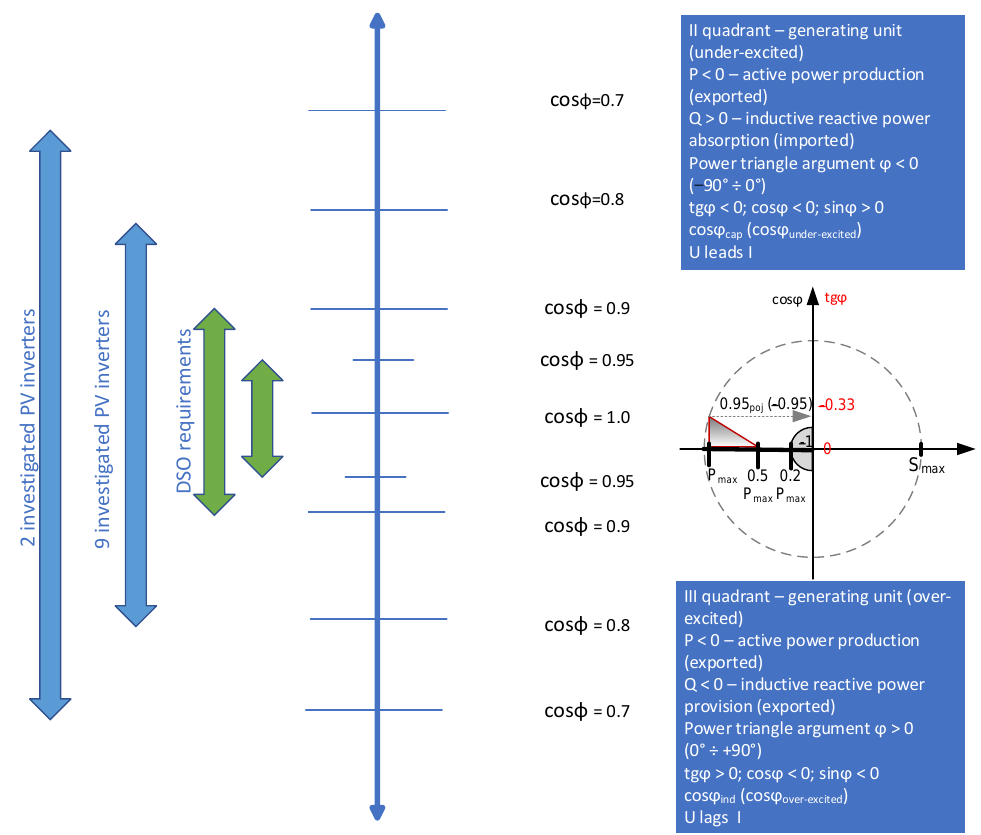
Figure 7. Identification of the maximum regulation capacity based on the technical data of the 11 analyzed inverters.